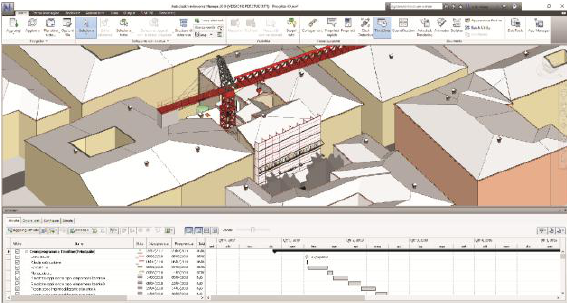
Figure 2. The management of the 4D was realized in